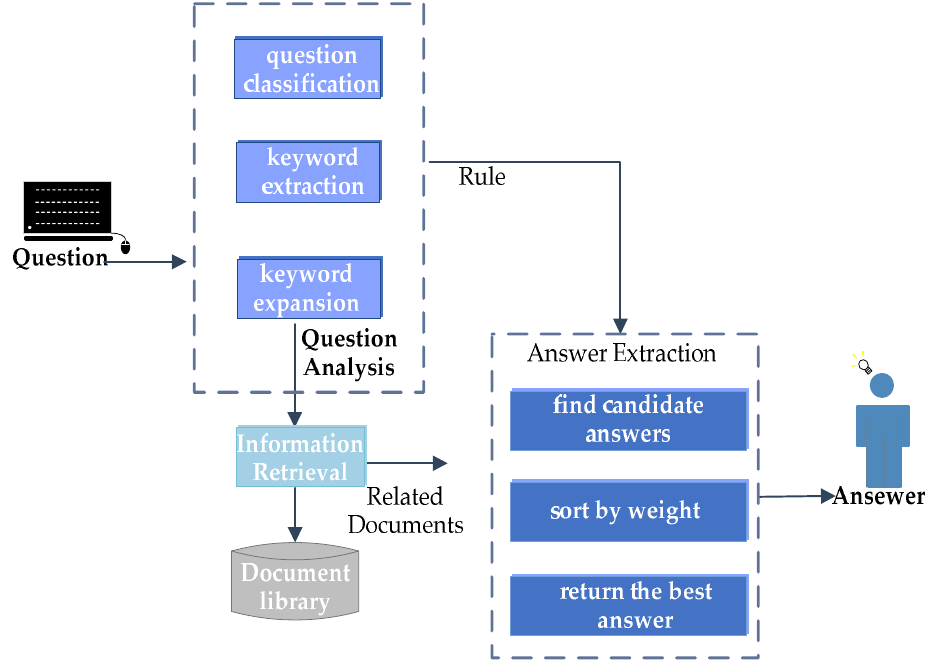
Figure 1. A typical QA system structure.